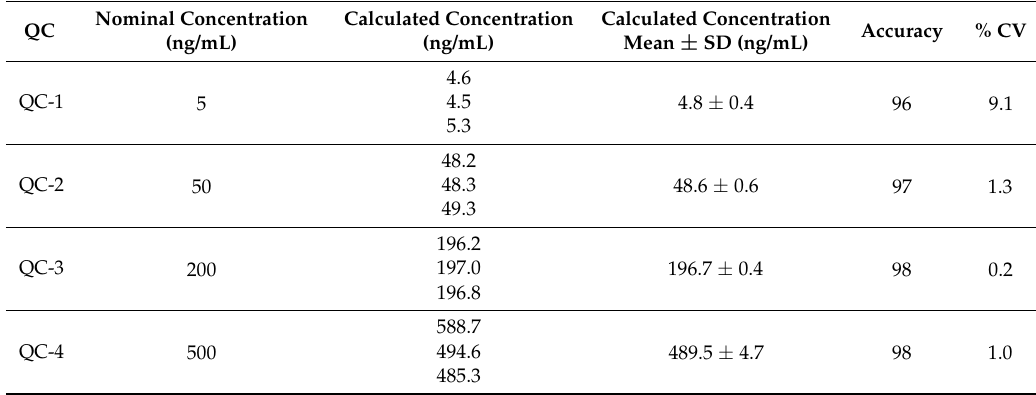
Table 3. Accuracy and precision Data of ICP-MS analytical